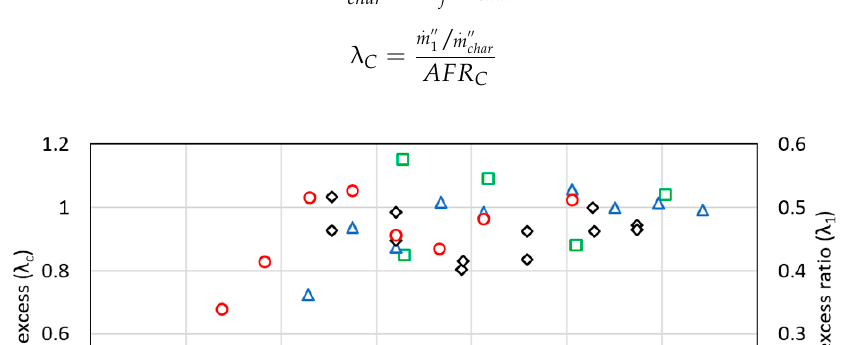
Figure 7. Primary ( λ 1 ) and char ( λ C ) excess ratios versus total airflow rate.